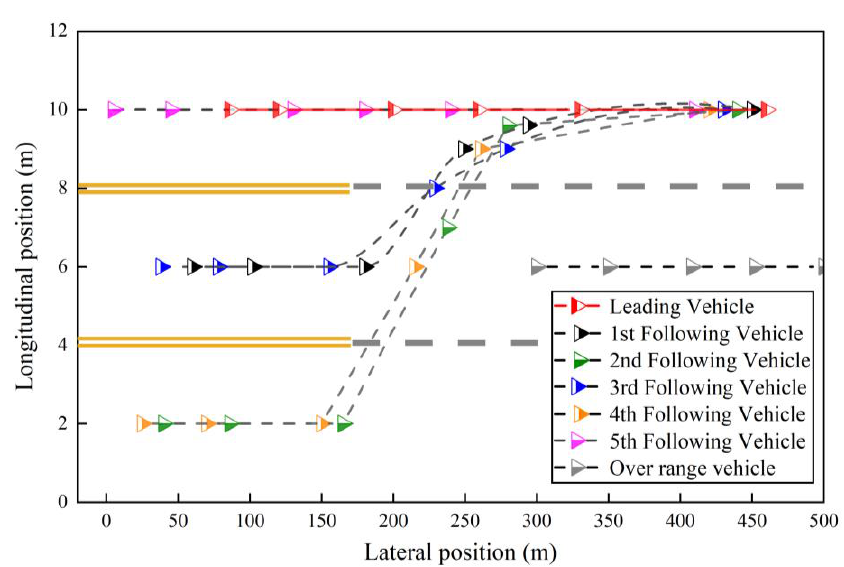
Figure 7. The trajectories of the CAVs during the platoon formation process (scenario II).